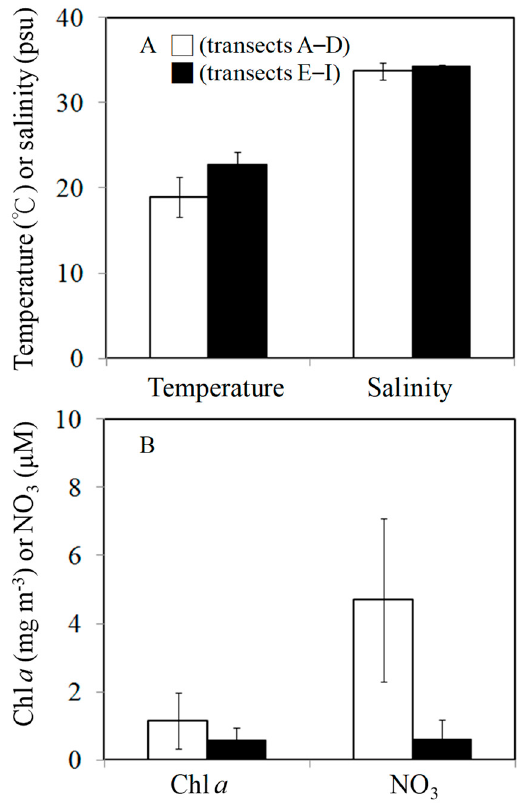
Figure 2. Mean values were determined from the transects A–D ( □) and transects E–I ( ■) for temperature and salinity ( A ) and for Chl a and NO 3 ( B ).